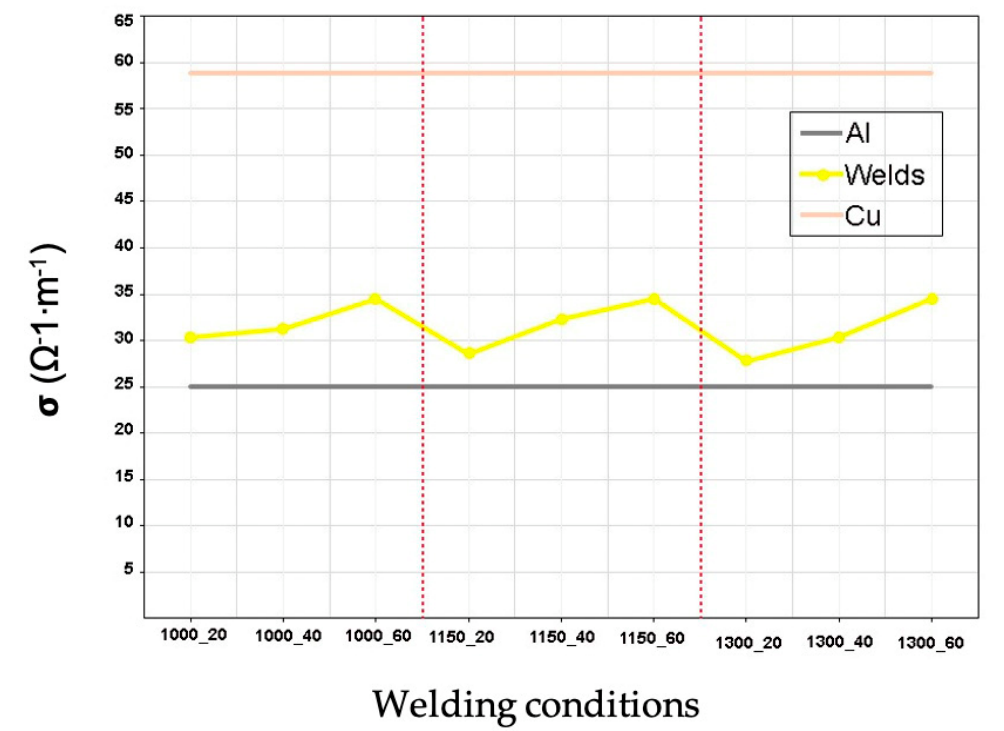
Figure 15. Effect of process parameters on the average electrical conductivity for the weld and the base materials.